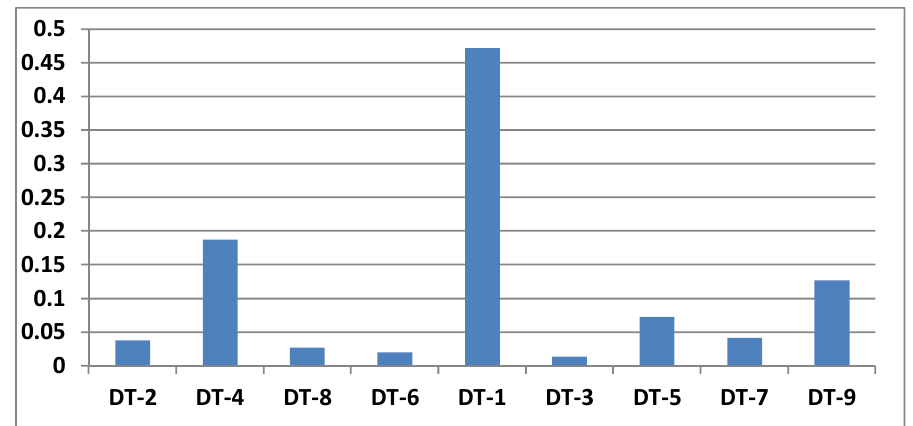
Figure 3. Assessment results of contribution rates. Table 3. Information of elements in the requirement mapping model.